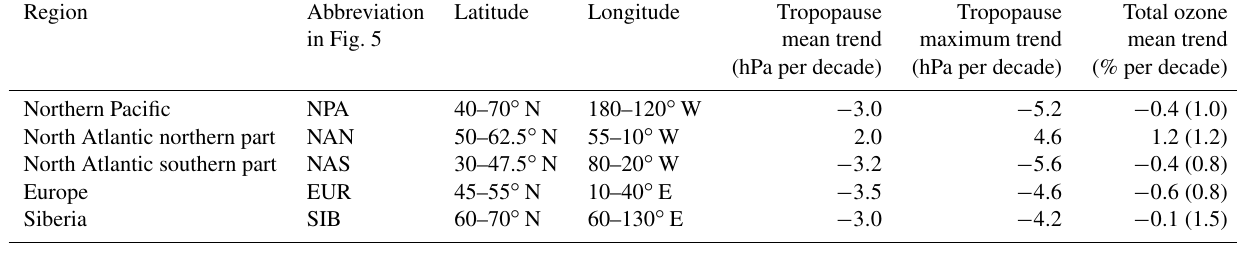
Table 3. Average and maximum linear trends in tropopause pressure (in hPa per decade), as well as average linear trend in total ozone and corresponding 2 σ uncertainty (in parenthesis; in % per decade) for five selected regions in the Northern Hemisphere (see also Fig. 5, black rectangles).